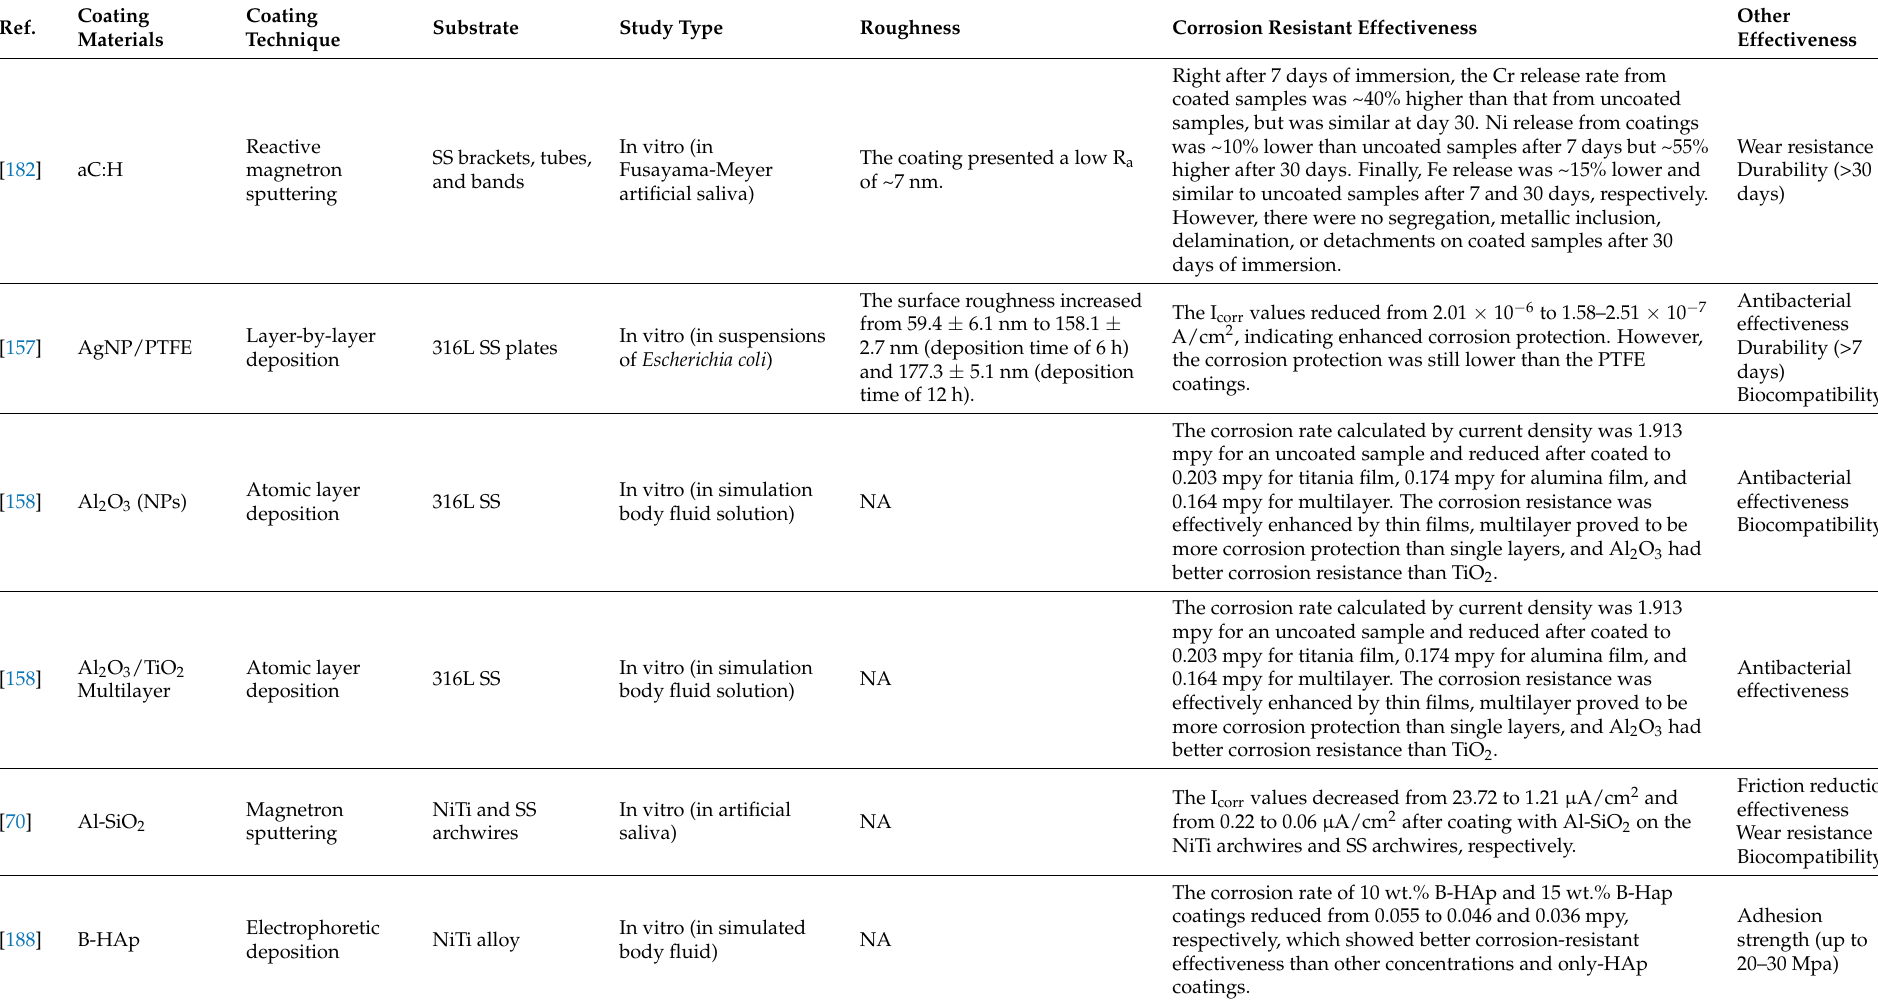
Table 3. Recent studies on corrosion-resistant coatings for orthodontic appliances.